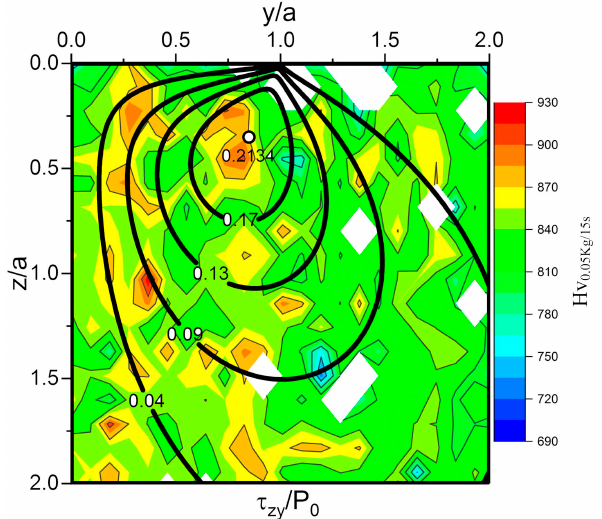
Figure 7. Hardness change of cylinder sample before and after experiment.